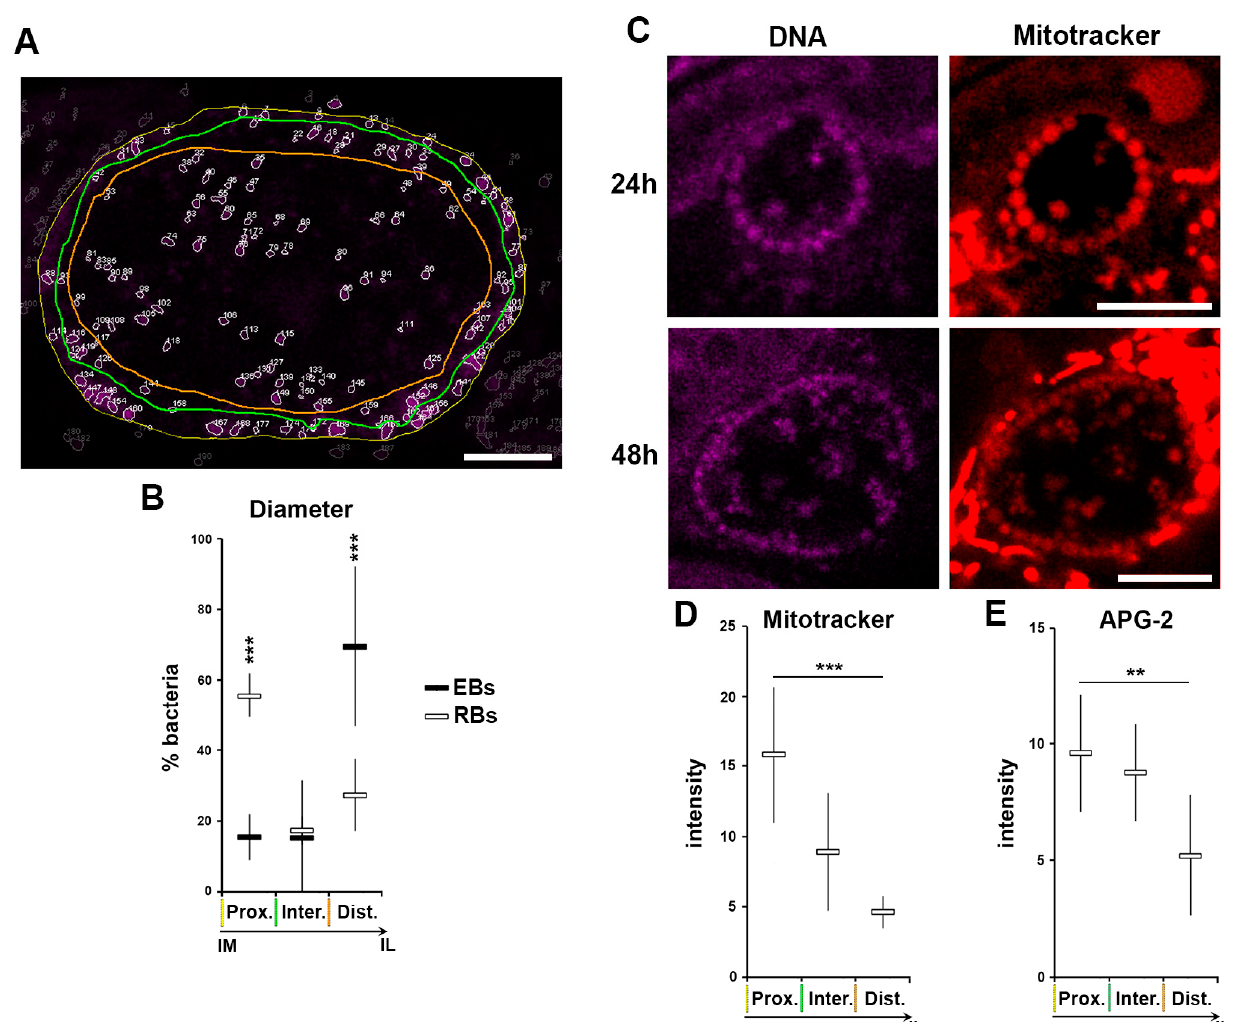
Figure 9. Loss of K + is associated to loss in membrane potential during RB to EB differentiation. HeLa cells were infected with C. trachomatis LGV2. All measurements have been performed on inclusions at 48 hpi. ( A ) An example of the segmentation experiments. The edge of the inclusion is highlighted with a yellow line, the region where the bacteria are in close proximity to the inclusion edge is outlined in green, and the luminal space of the inclusion by an orange line. Scale bar: 5 µm. ( B ) Bacterial diameter has been determined and a threshold applied to differentiate the elementary bodies (EBs), reticulate bodies (RBs) and intermediate bodies (IBs) (Figure 2E–H). The relative number (as a percentage) of each bacterial form is plotted against the position in the inclusion following the parameters established in previous panel (Prox.: directly proximal to the inclusion membrane, Inter: intermediate space, Dist.: distal to the inclusion membrane (luminal space). Coloured lines mirror those shown in previous panel. ***: p < 0.001. ( C ) At the indicated time point cells were incubated with Mitotracker and DNA probe (DRAQ-5) prior to imaging. Scale bar: 5 µm. ( D ) Mitotracker intensity was determined for RBs in different regions of the inclusion defined in the previous panels ( A and B ) ***: p < 0.001. ( E ) APG-2 intensity was determined for RBs position in different regions of the inclusion as in previous panel ( A and B ) **: p < 0.1, ***: p < 0.01.